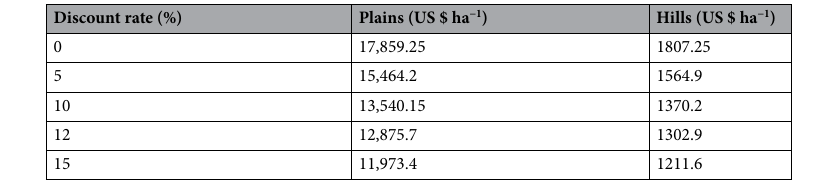
Table 5. Net present value of the benefits to the local communities from participating in the payments to encourage coexistence programme for 5 years. @ 2014 prices.